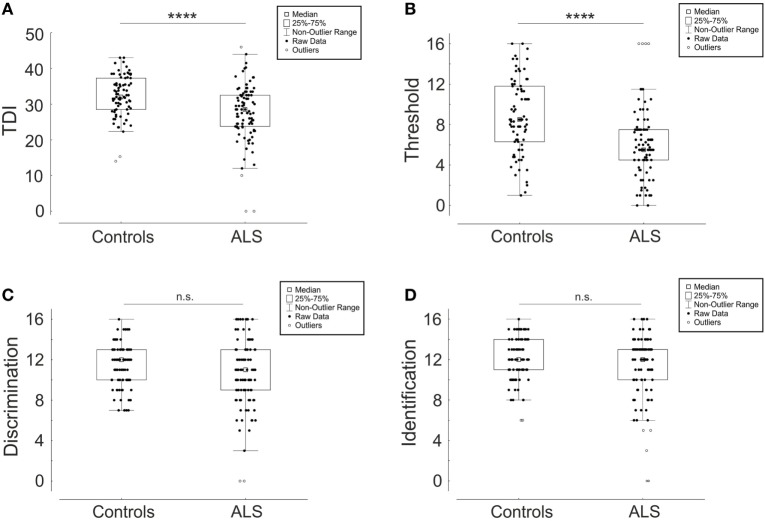
Comparison of “Sniffin Sticks” test results between amyotrophic lateral sclerosis (ALS) patients and healthy controls depicted as box plots with single values (dots). TDI score (A) is a composite of the three subtests threshold “T” (B), discrimination “D” (C), and identification “I” (D). ****p < 0.0001, not significant (n.s.).